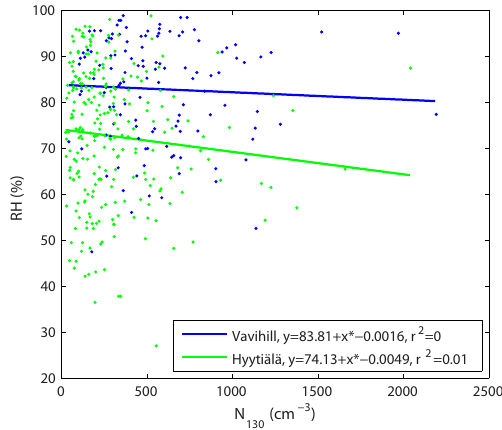
Figure 5. Relationship between relative humidity (RH) and aerosol number concentrations above 130nm (N 130 ) for Vavihill (blue) and Hyytiälä